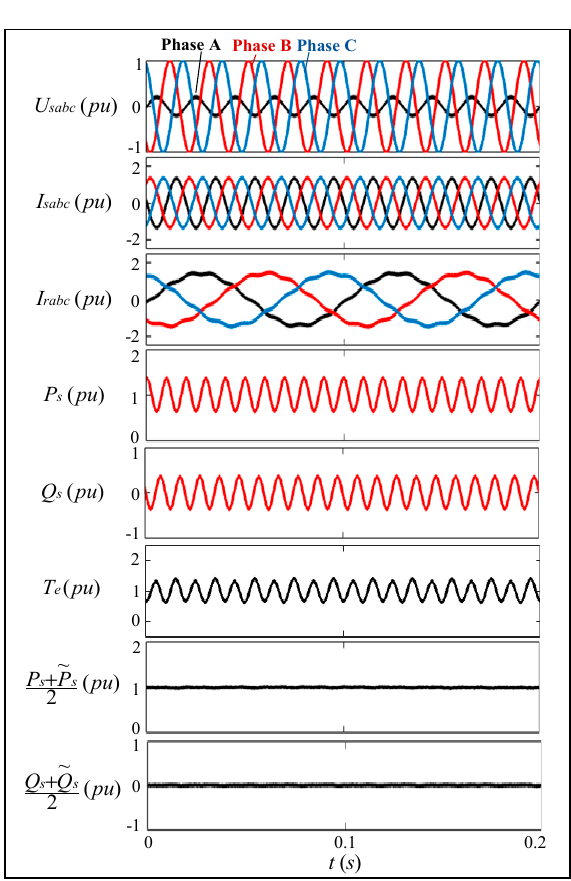
Figure 12. Proposed VSG control under a single-phase grid voltage drop of 80% (Target 2).